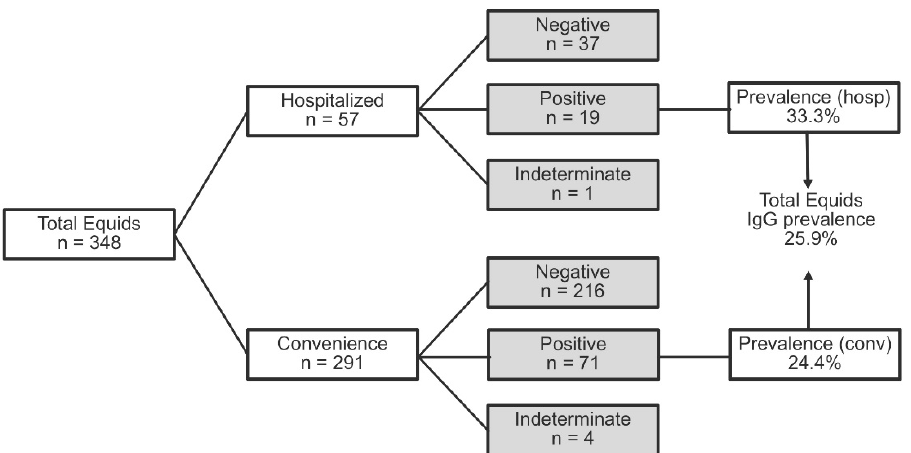
Figure 1. Laboratory results of IgG ELISA detecting flavivirus antibodies in serum. Abbreviation (hosp) refers to hospitalized equids and (conv) to convenience field sampled equids.